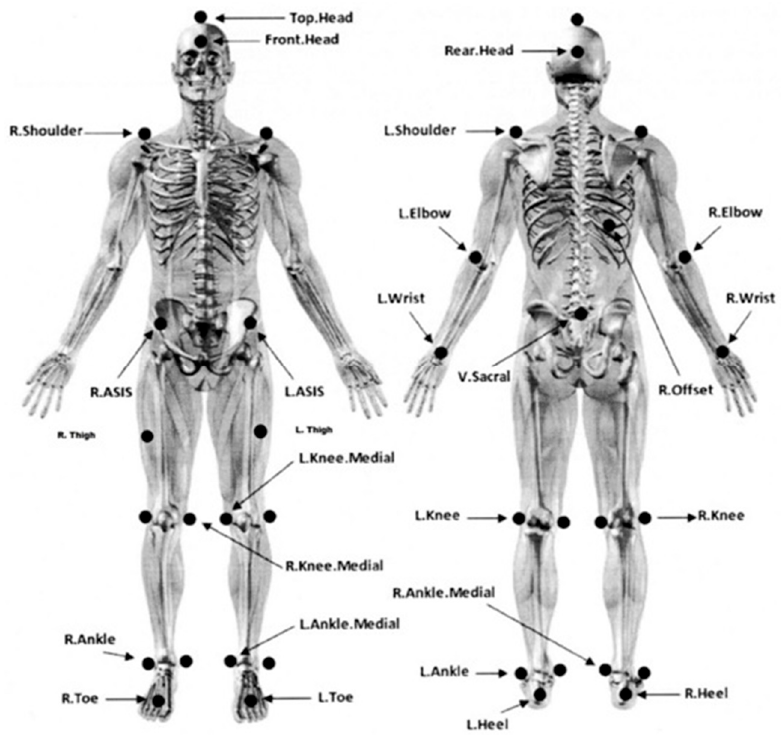
Figure 2. Marker placement.